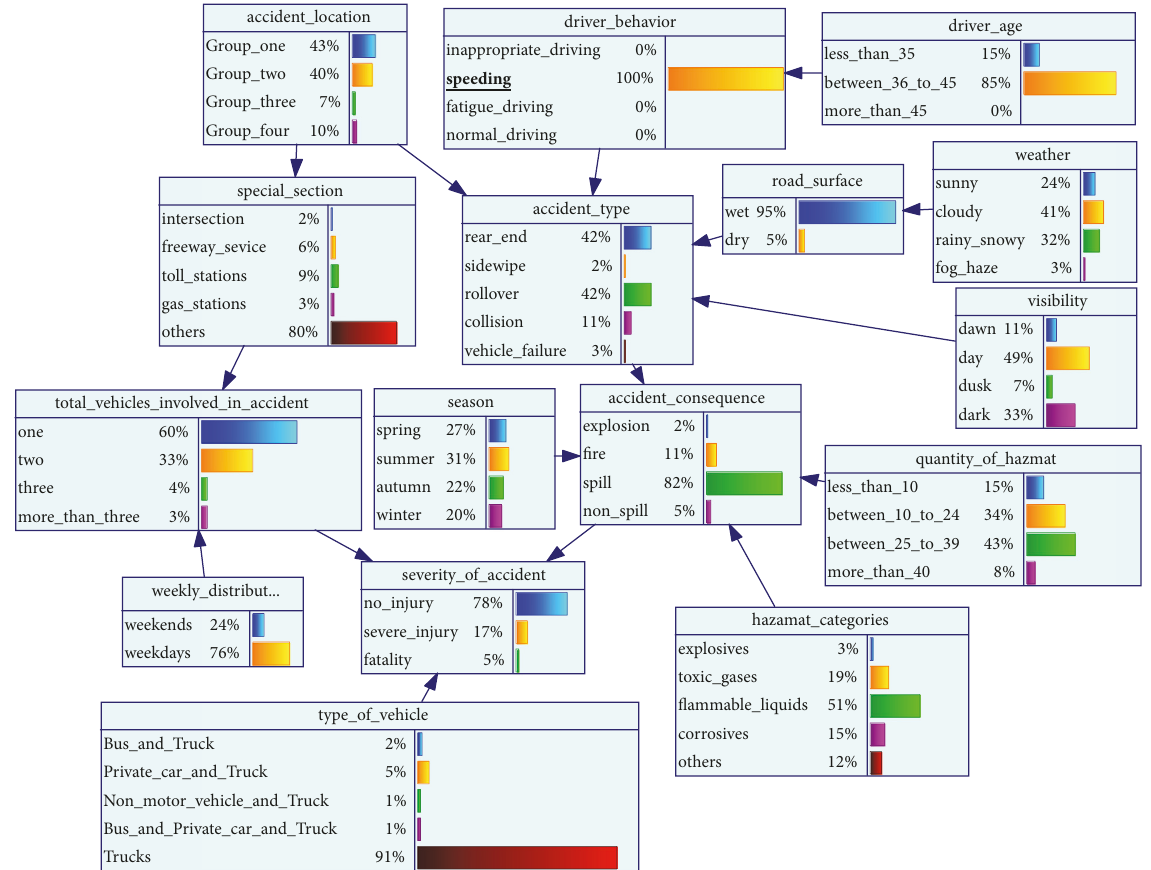
Figure 5: Accident prediction when the evidence variable is